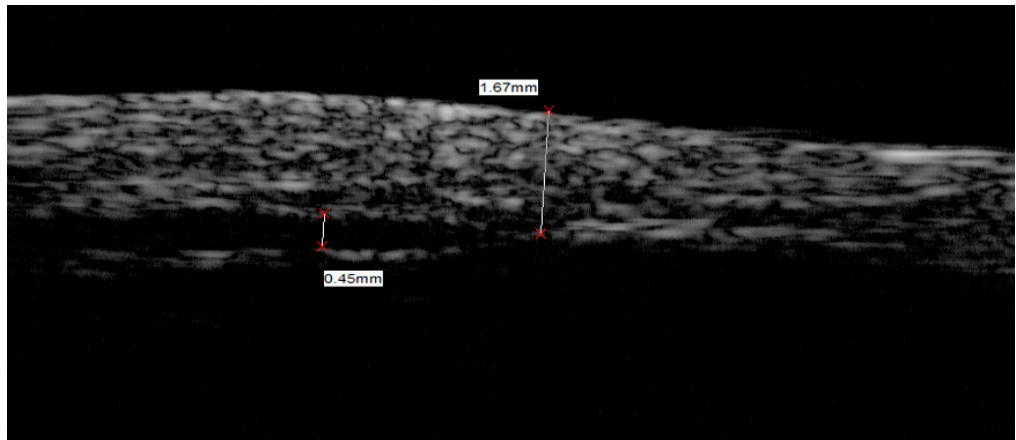
Figure 9. Image of human skin from the back of the hand, generated by BNT-BT transducer using Ultrasound Bio-Microscope (UBM).